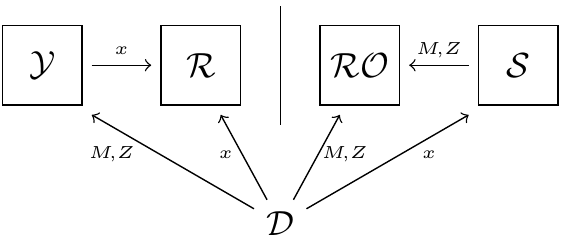
Figure 5: The indifferentiability setting. Distinguisher D is confined to making construc- tion queries ( M, Z ) such that Z = Z ( | M | , A ) for some A . The labels indicate the input to the oracles. Oracle R / S receives as additional input the requested length of the response (if it is an arbitrary function), the direction of the query (if it is a permutation), or the key input and the direction of the query (if it is a block